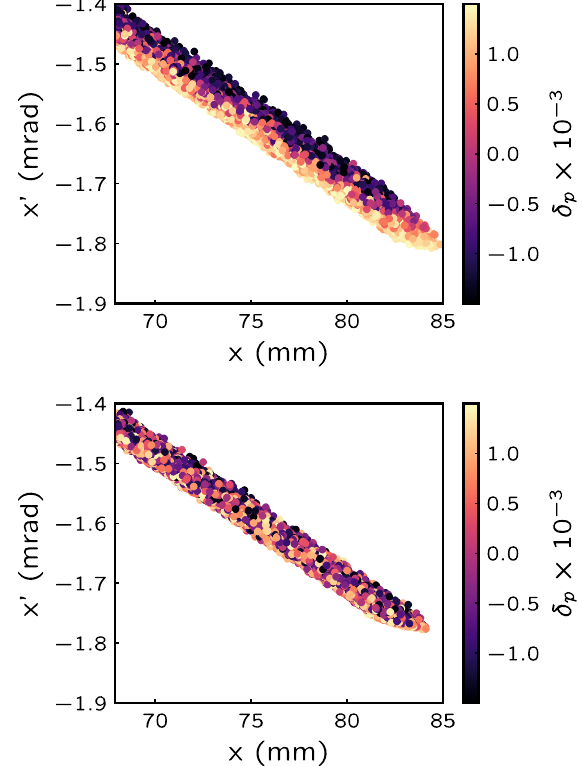
FIG. 5. Phase space plot of extracted beam at SPS ES entrance for entire spill from simulation. The upper plot was obtained with conventional tune sweep extraction and the lower plot with COSE. The correlation between x 0 and particle momentum disappears for COSE and the angular spread at the ES is reduced.